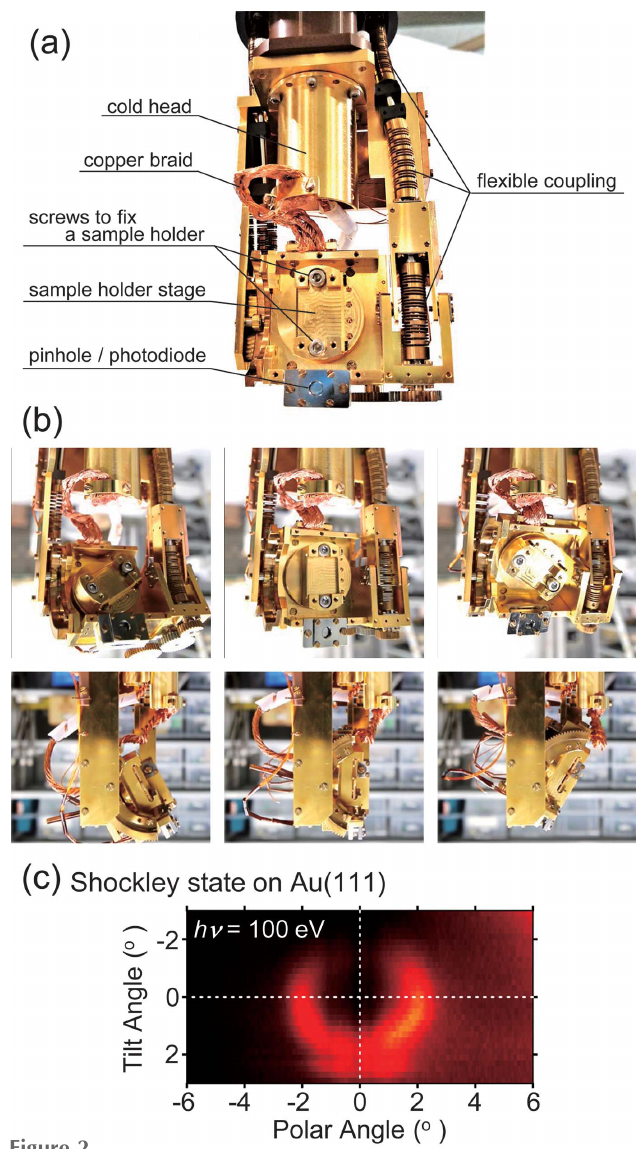
Figure 2 ( a ) Front image of the two-axis cryogenic sample goniometer (iGONIO- FC). ( b ) Front and side views (upper and lower images, respectively) of azimuthal and tilt rotations of the sample-holder stage. ( c ) A Fermi surface cut of Au(111) measured by right-circular polarization light at h (cid:2) = 100 eV (300 lines mm (cid:2) 1 VLSG). A center circle corresponds to the Shockley state, which is visualized by integrating the photoemission intensity between (cid:2) 0.05 and +0.05 eV in binding energy. A series of ARPES spectra were acquired by an angular mode of the SES200 analyzer with an effective acceptance angle of about (cid:6) 6 (cid:4) (in the polar angle direction), and the tilt angle was scanned from (cid:2) 3.0 (cid:4) to +3.0 (cid:4) with a 0.20 (cid:4) step. The exit-slit width was 30 m m, and the total energy resolution was set at 0.11